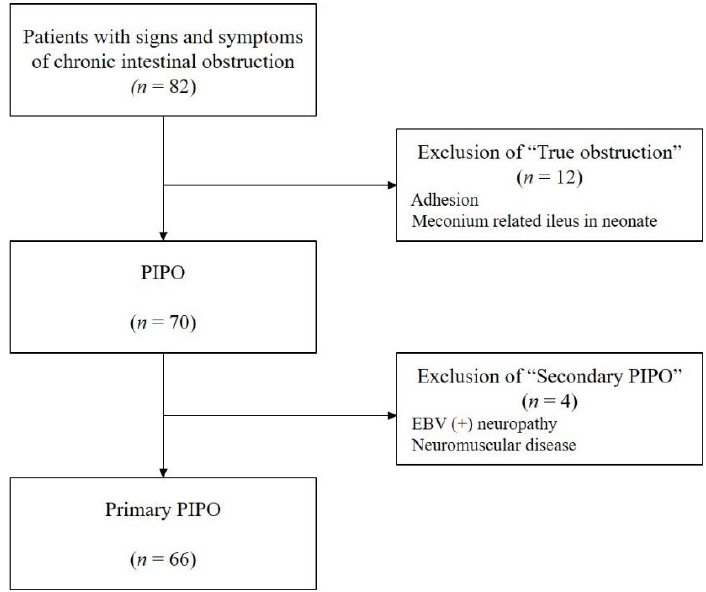
Figure 1. Diagnostic flow.